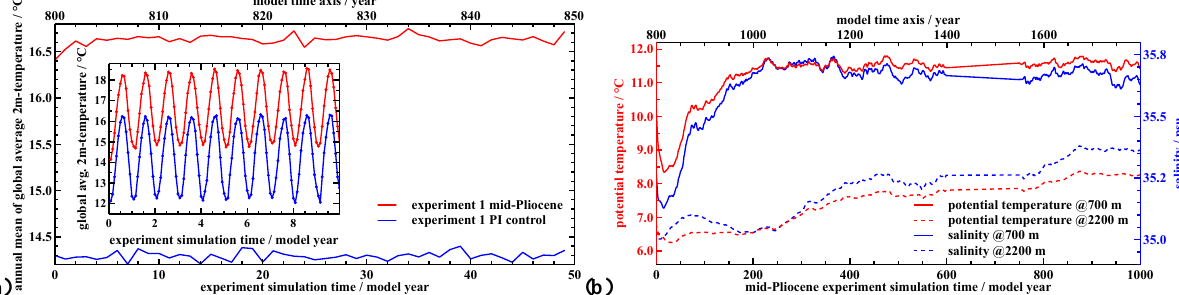
Fig. 6. (a) Evolution of yearly average 2-m temperature in experiment 1. The atmosphere adjusts to the change in climate forcing very fast (cf. the inset that shows a monthly resolved time series of the first 10 simulation years), and reaches an equilibrium state in less than ten years. (b) Annual mean North Atlantic Ocean temperature and salinity at 700 m and 2200 m in the mid-Pliocene simulation of experiment 2. Starting point of the simulation is a temperature-adjusted PI control state at year 800 of the model time axis (see text for details). Output between model years 600 and 749 is missing, as indicated by the straight progression of the